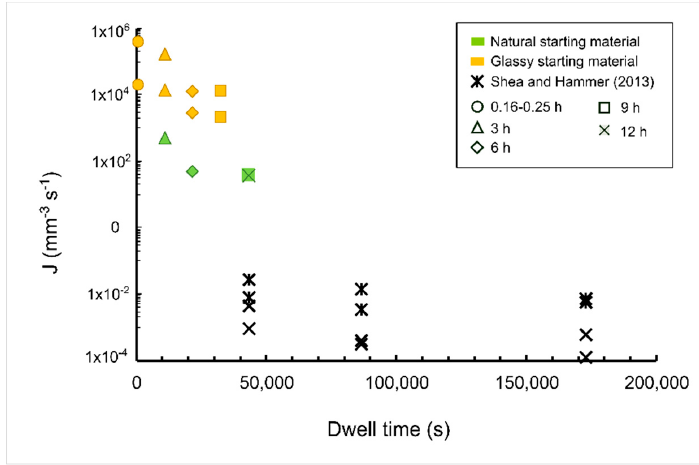
Figure 6. Relation between the nucleation rate ( J ) and the experimental time. Symbols are as in Figure 2. Black asterisks indicate the single step cooling runs ( Δ T eff = 52–82 °C) of Shea and Hammer [17].